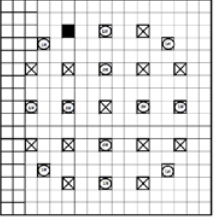
Figure 2. The structure of primary neutron-source